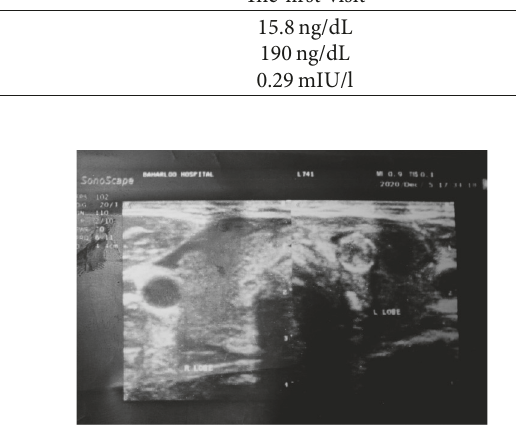
Figure 1: Thyroid ultrasound findings.